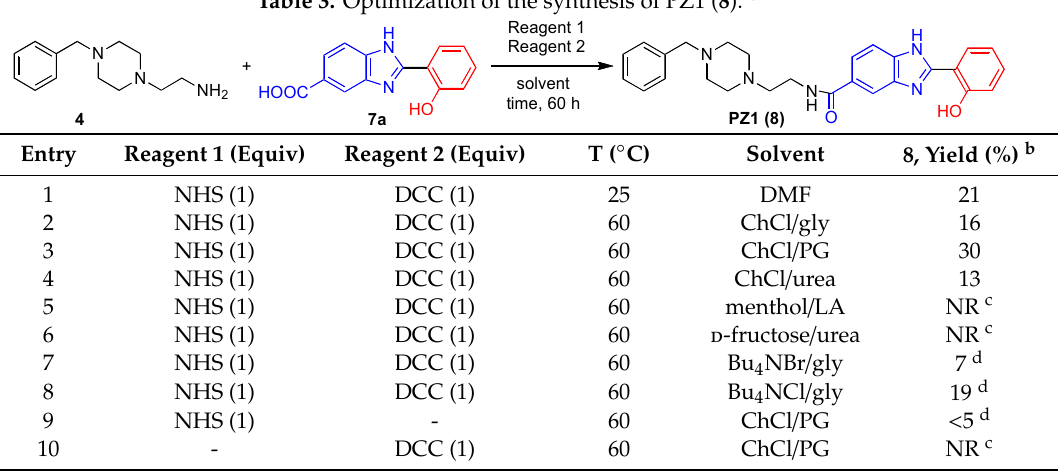
Table 3. Optimization of the synthesis of PZ1 ( 8 ). a